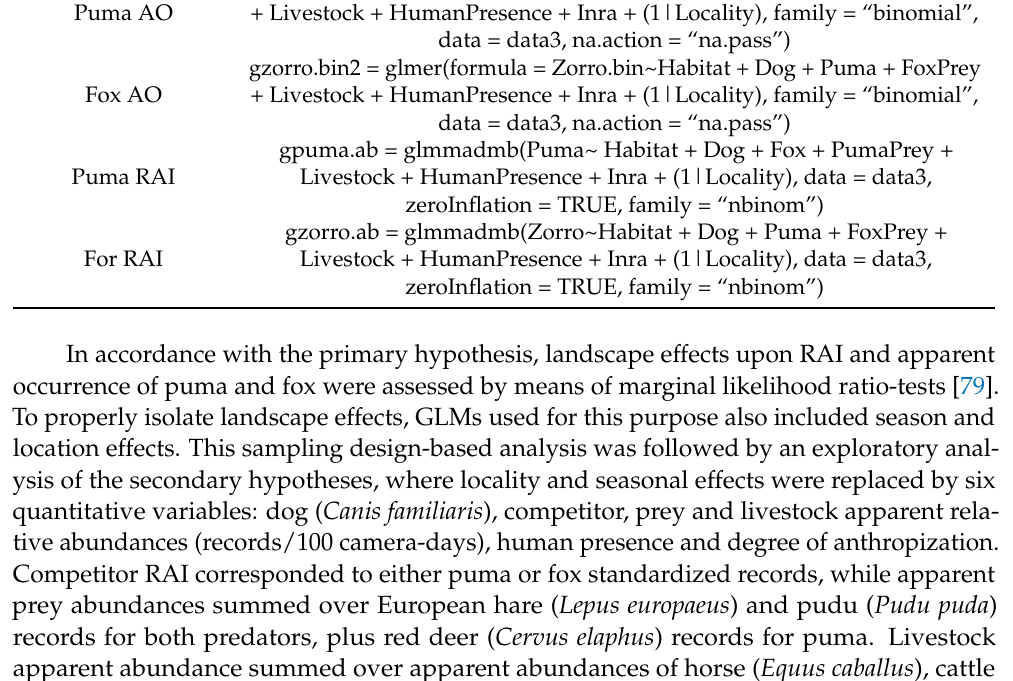
Table 1. ModelusedtoestimatetheapparentoccurrenceandRAIofpumaandfox. AO=Apparentoccurrence. Puma Model in R Puma